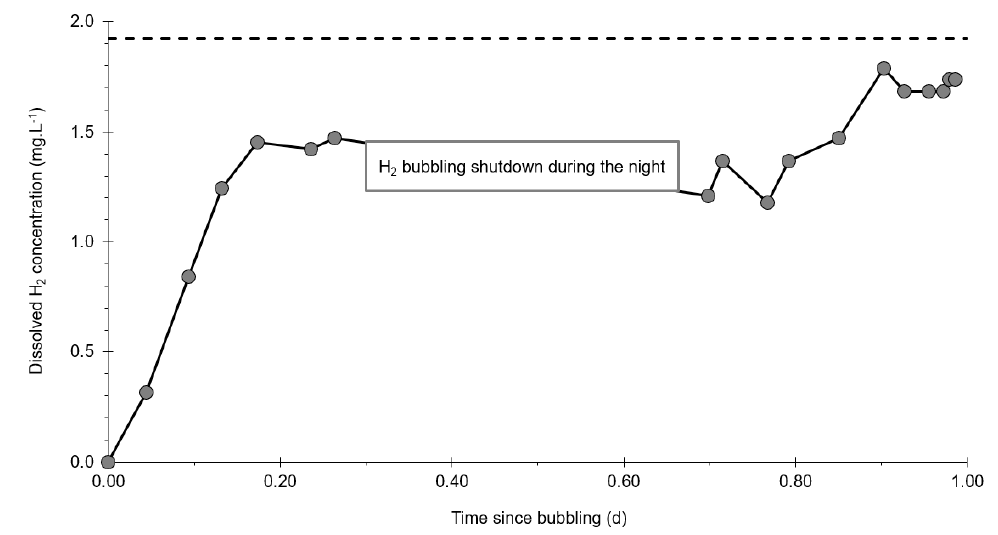
Figure 6. Evolution of the dissolved hydrogen concentration of the water in the second tank during bubbling (measured by partial degassing after mechanical agitation; the dashed line corresponds to saturation).